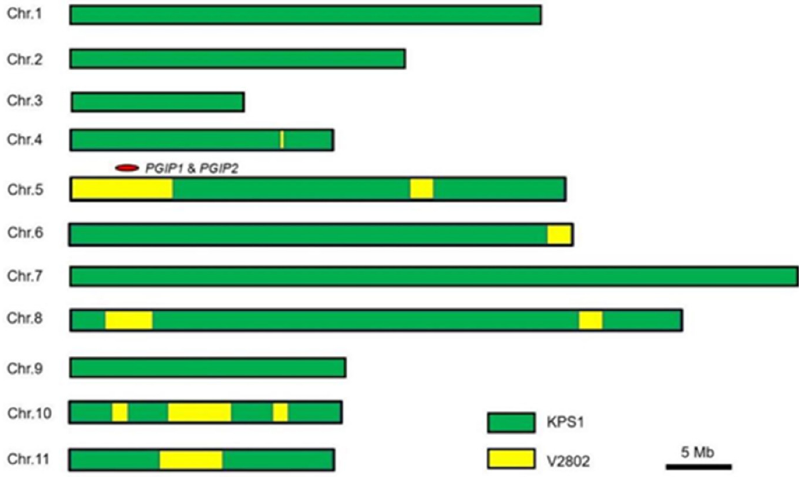
Figure 5. Genetic background of R67-22 determined by whole-genome resequencing.